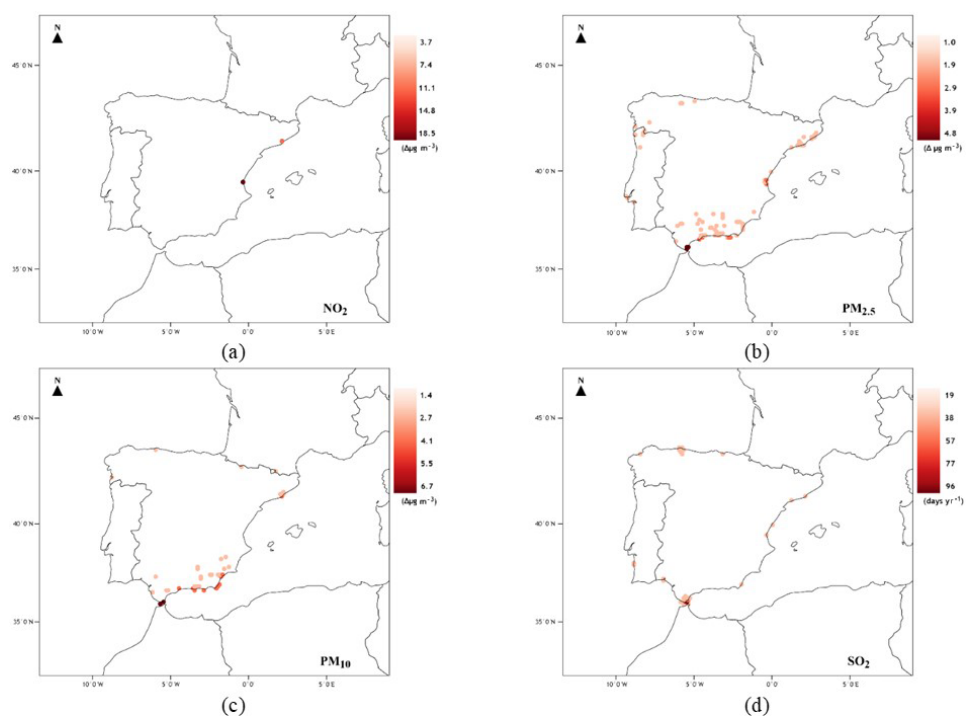
Figure A2. Spatial distribution of the contribution of shipping emissions (concentration increment) to the inland exceedances for (a) NO 2 , (b) PM 2 . 5 , and (c) PM 10 as well as the number of days per year that the threshold value was exceeded in a given grid cell for (d) SO 2 .